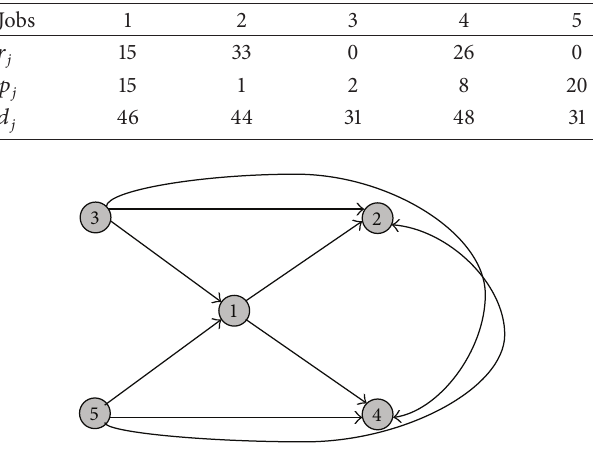
Figure 4: Disjunctive graph of the 5-job instance of Example